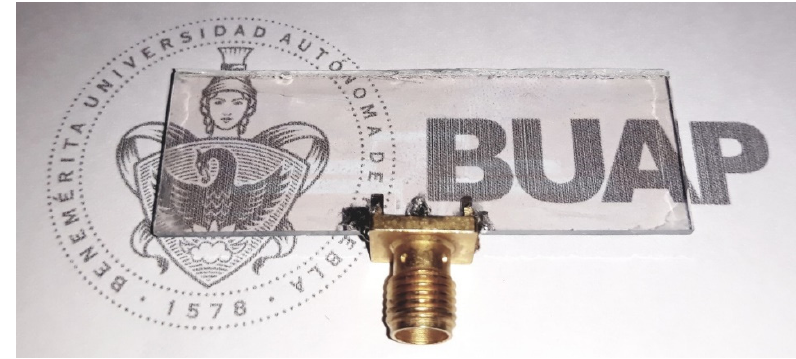
Figure 4. Manufactured antenna photography.